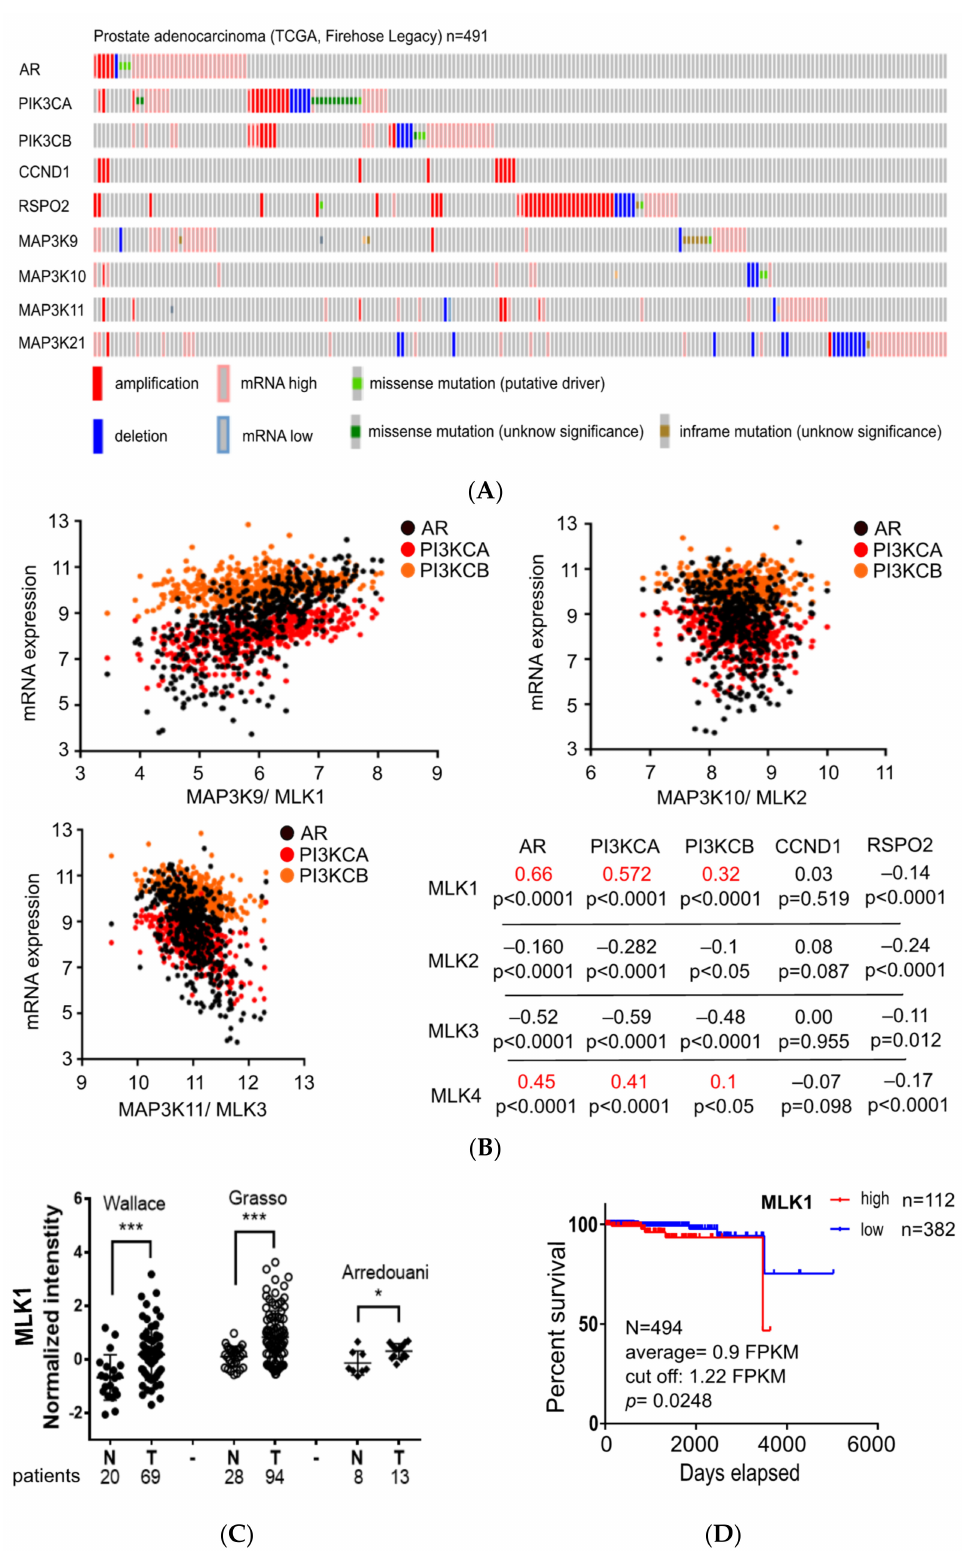
Figure 1. MLK1 mRNA expression is associated with prostate cancers. ( A ) Analyses of genetic alterations with a prostate cancer dataset (TCGA, Firehose Legacy) using the cBioPortal server. Each box represents a patient. ( B ) Correlation analysis for four MLK genes (MLK1-MLK4) with frequently-mutated genes (AR, PI3KCA, PI3KCB, CCND1, and RSPO2) identified in mCRPC. Correlation coefficients with positive values and statistical significance ( p < 0.05) are labeled red. ( C )